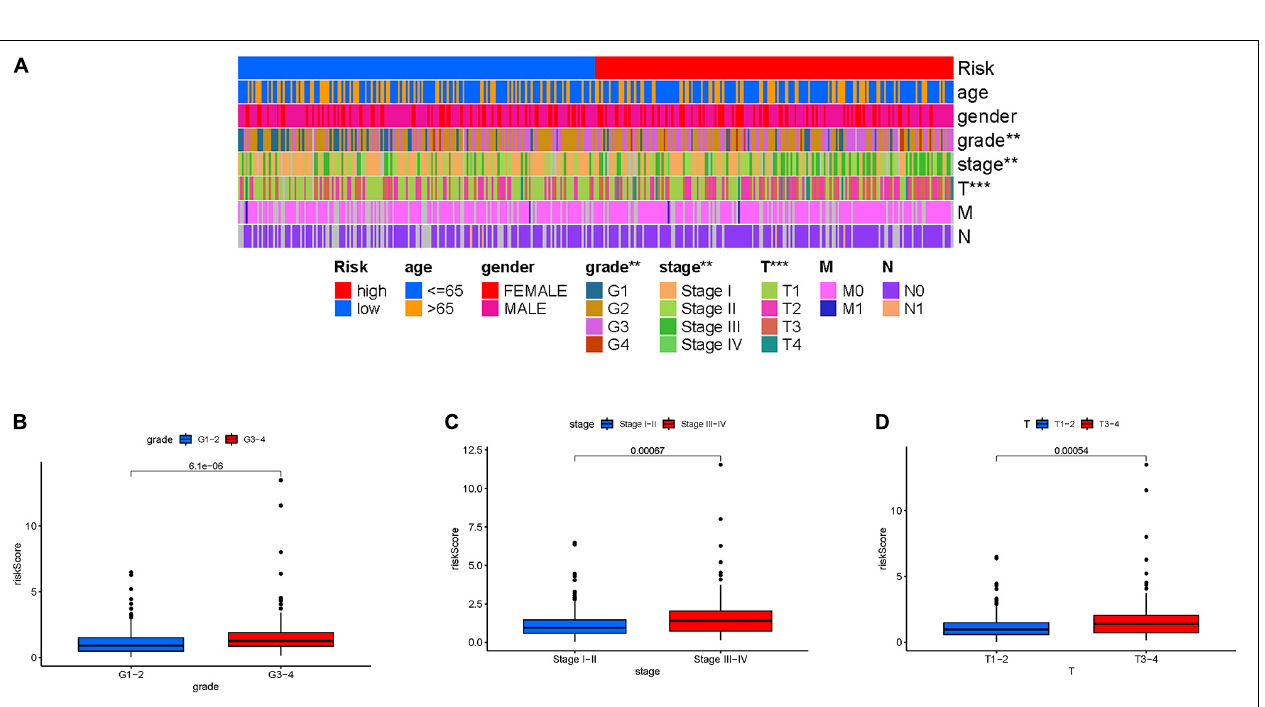
FIGURE 5 | Clinical significance of the prognostic risk signature. (A) Heatmap presents the distribution of clinical feature and corresponding risk score in each sample. Comparison of risk score among different subgroups classified by clinical characteristics: (B) WHO grade, (C) clinical stage, and (D) T status.